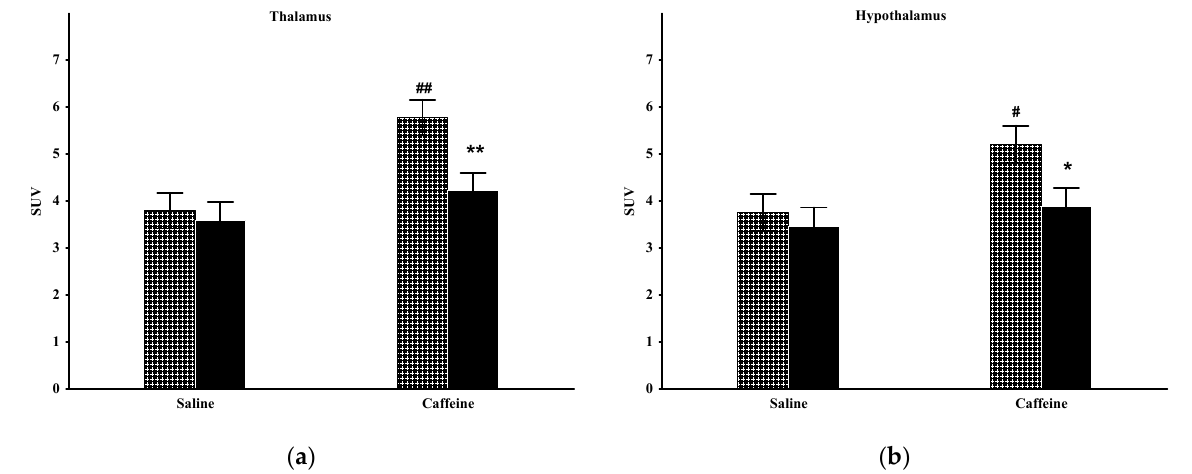
Figure 4. The mean 18 F-FDG PET SUV with standard error bars in the thalamus ( a ) and hypothalamus ( b ) of control and Wisket animals with saline/caffeine applied one day before PET scan. Symbols denote significant differences between the two groups (* or **) compared to saline (# or ##); p < 0.05 or p < 0.01 with one or two symbols, respectively.